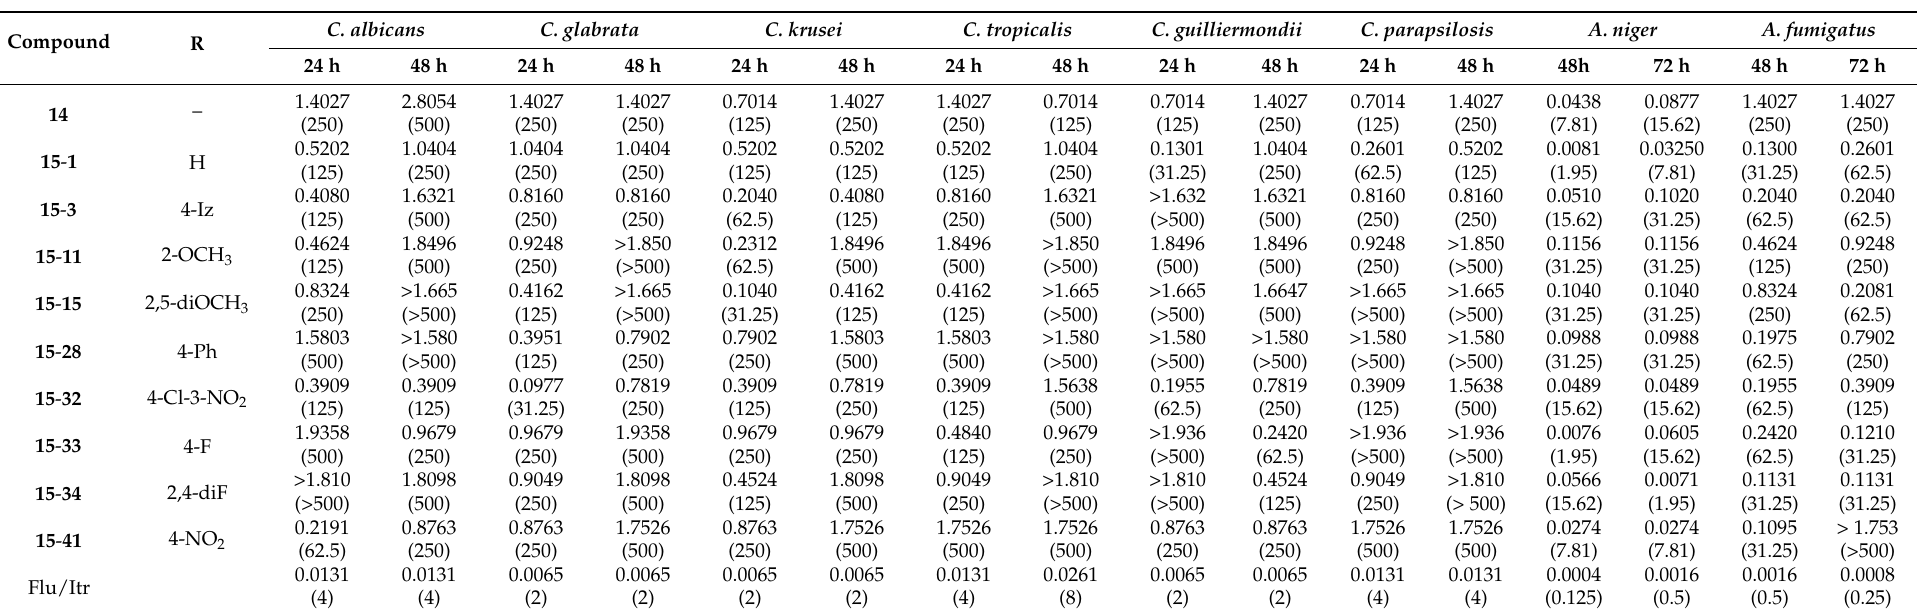
Table 5. Summary of the MIC values in vitro of 14 and 15 for yeasts and filamentous